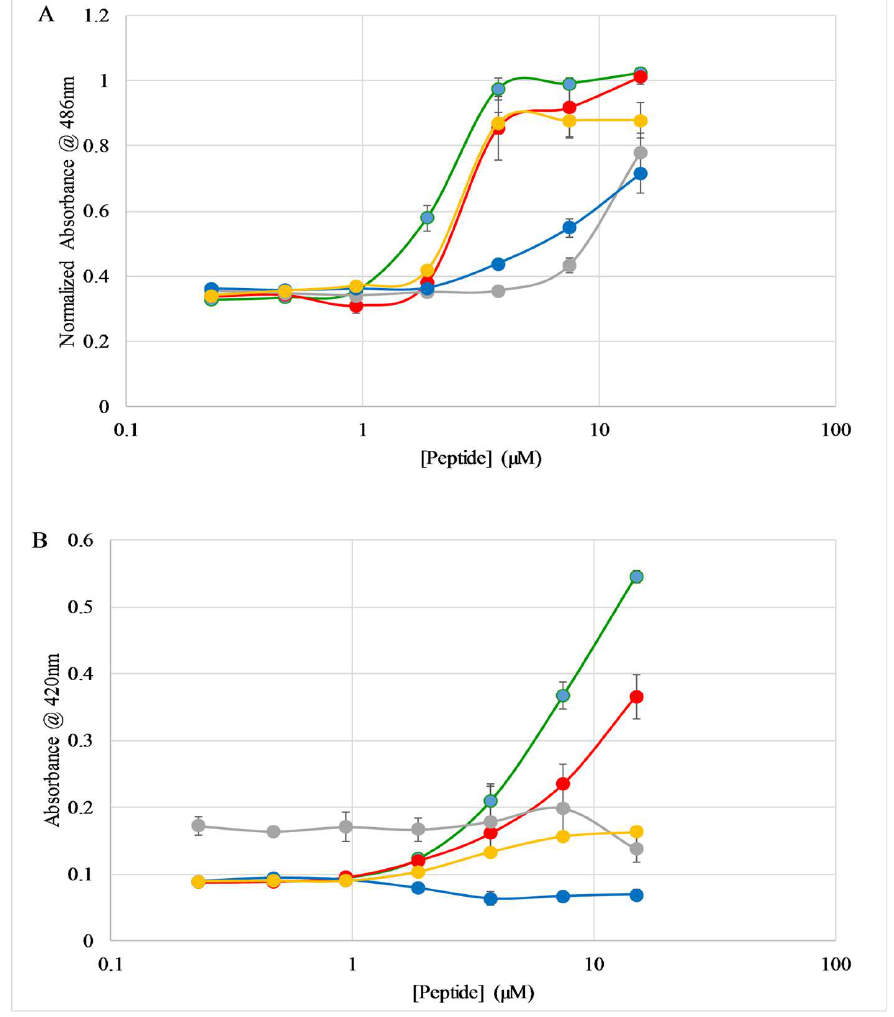
Figure 4. E. coli membrane permeabilization. Chromogenic substrate breakdown after 30 min of exposure to peptides. ( A ) Outer membrane permeabilization assayed by nitrocefin breakdown. ( B ) Inner membrane permeabilization assayed by ONPG breakdown. In both panels colors represent C18G (green), C18G-Arg (red), C18G-His (gray), C18G-Orn (orange), C18G-Dap (blue). All data is the average of at least 3 replicates, where error bars represent the standard